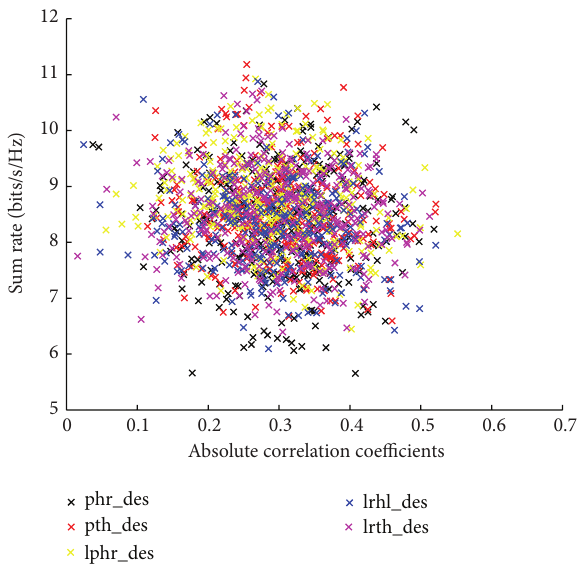
Figure 9: Scatter plot: capacity versus correlation for desired links at high band.